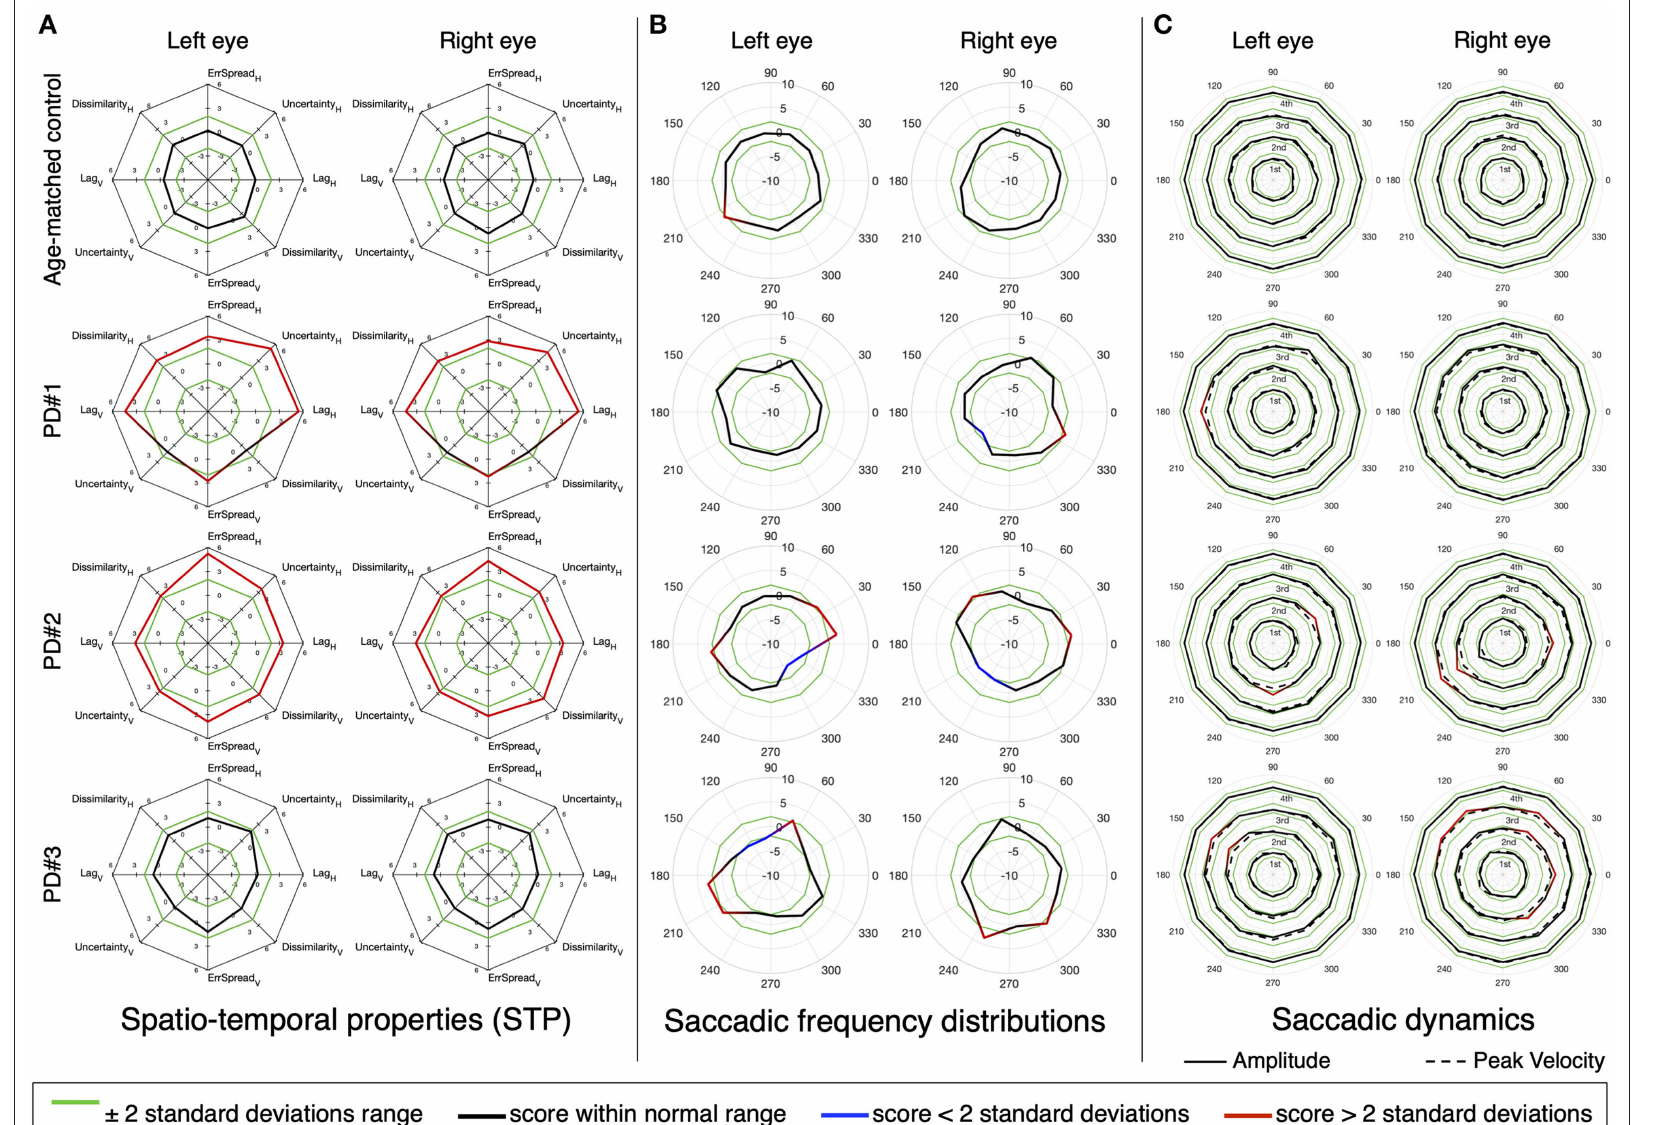
FIGURE 8 | Same as Figure 7 . and significantly different amplitude and velocity (Figurxxe). Overall the PD group showed more significant deviations from controls compared to the MS group